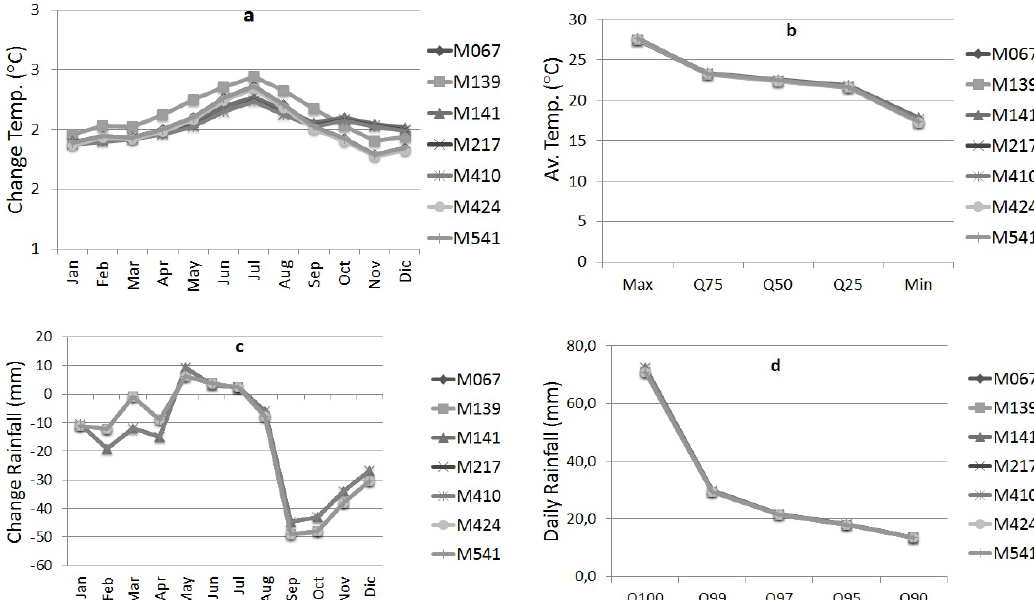
Fig. 6. Temperature and rainfall properties obtained from the average of ensemble GCM-RCM simulations (2045–2065). (a) Monthly average temperature distribution, (b) monthly temperature for different quantiles, (c) monthly rainfall depth distribution, (d) daily rainfall depth for different